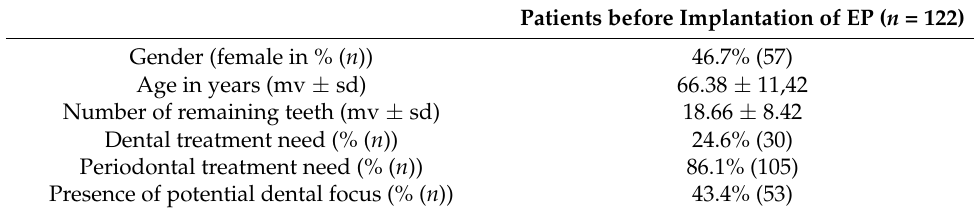
Table 1. Patient characteristics cross-sectional part of the study ( n = 122).